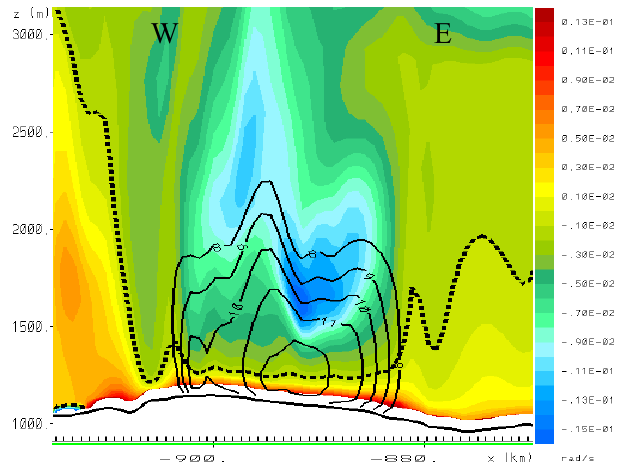
Fig. 7. Wind speed (solid black contours from 8–12ms − 1 ev- ery 1ms − 1 ) and ξ relative vorticity component (colour scale) at 12:50UTC for a WE vertical cross-section at y = − 645km. The dashed black line represents ξ =